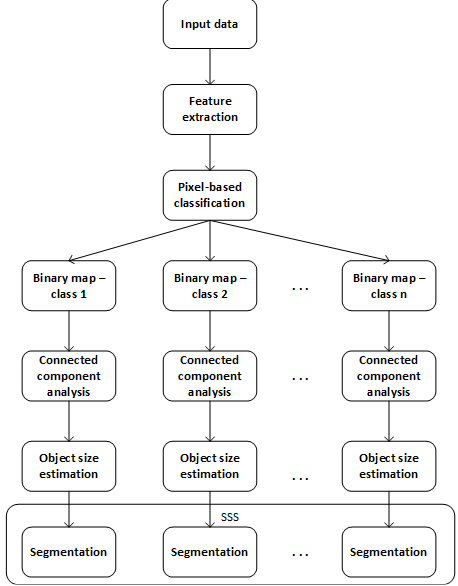
Figure 2. Process of generating segmentation scale